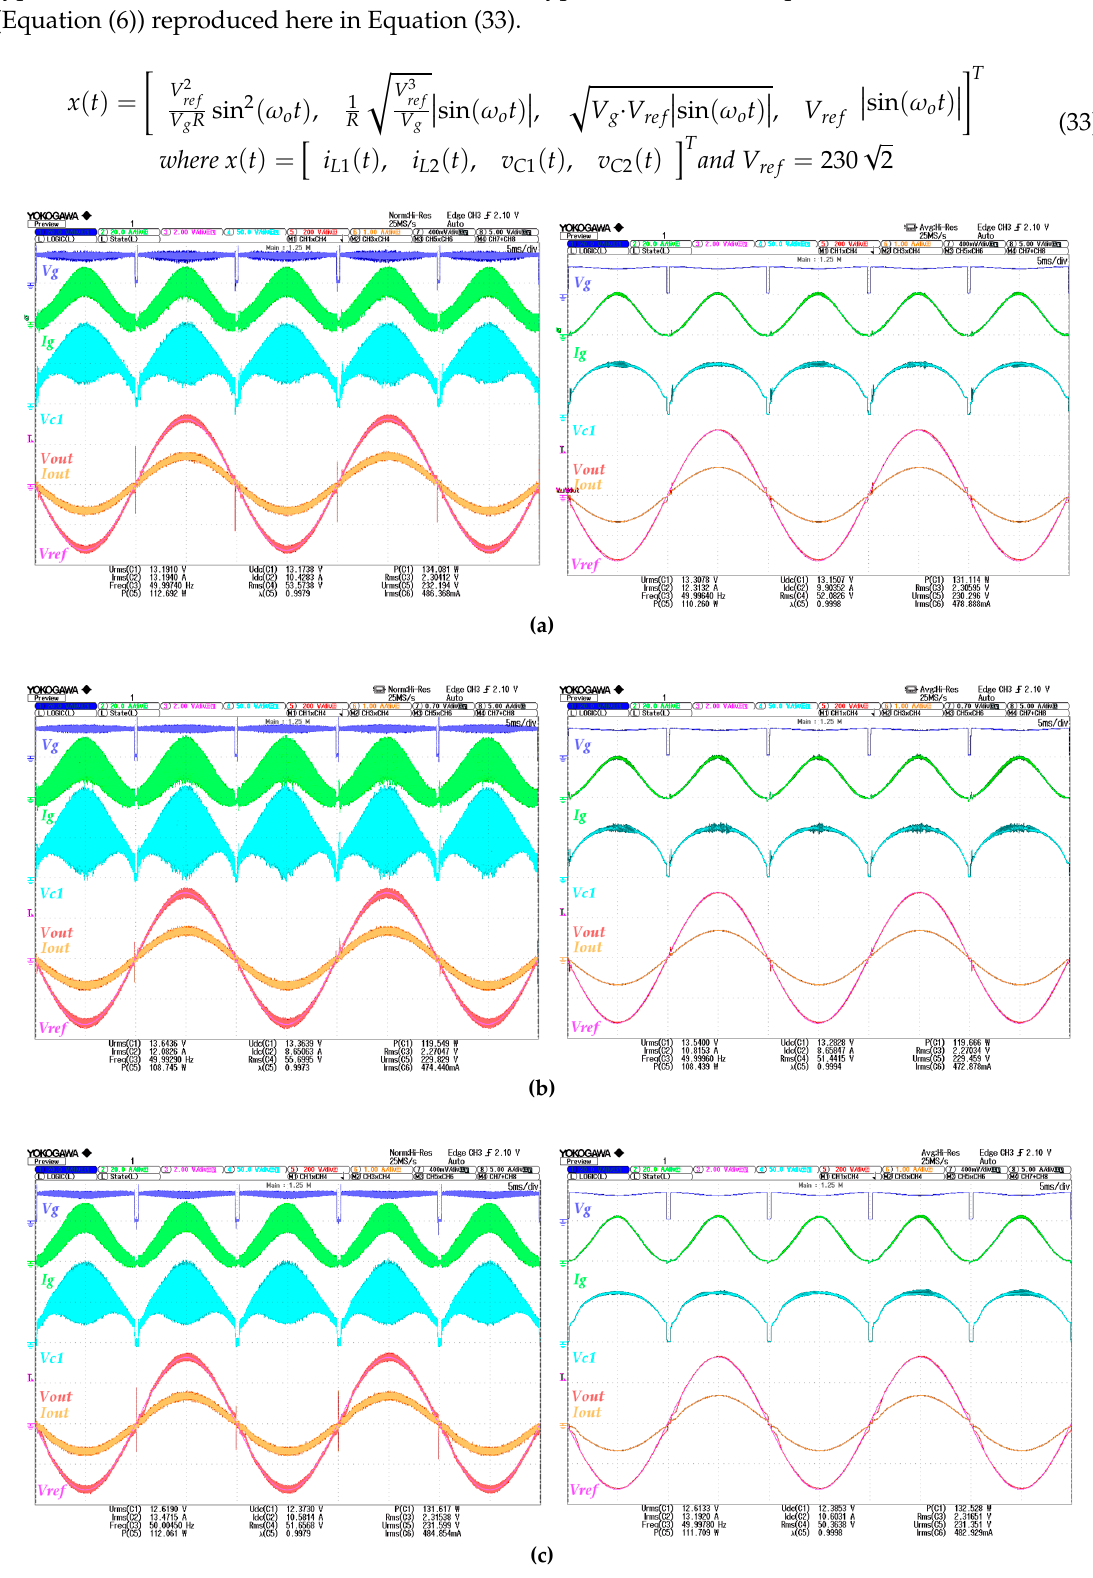
Figure 27. Microinverter captions at 100 W under different conditions. ( a ) Input current control and constant hysteresis. ( b ) Input current surface and variable hysteresis, and ( c ) self-oscillating surface and variable hysteresis.